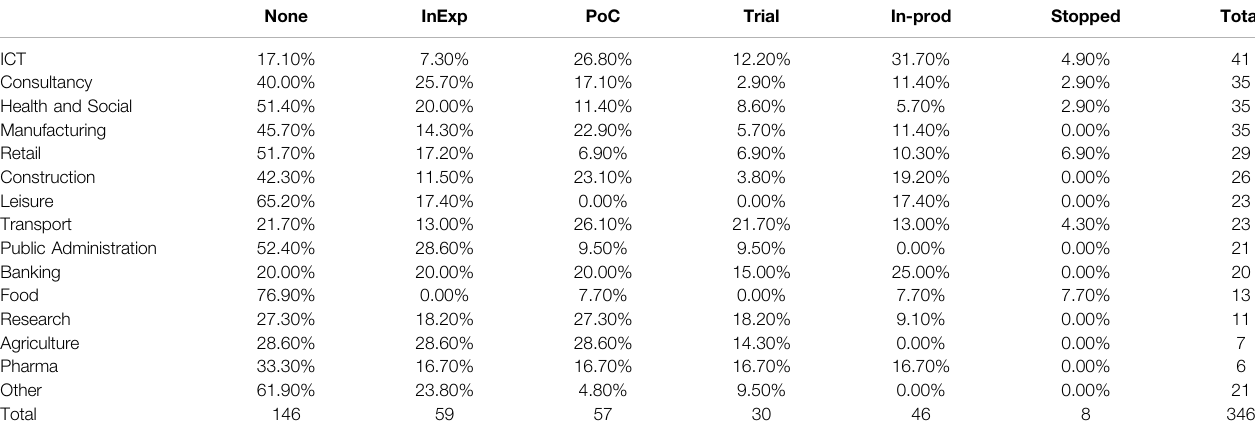
TABLE 3 | Distribution of blockchain stage within industry.